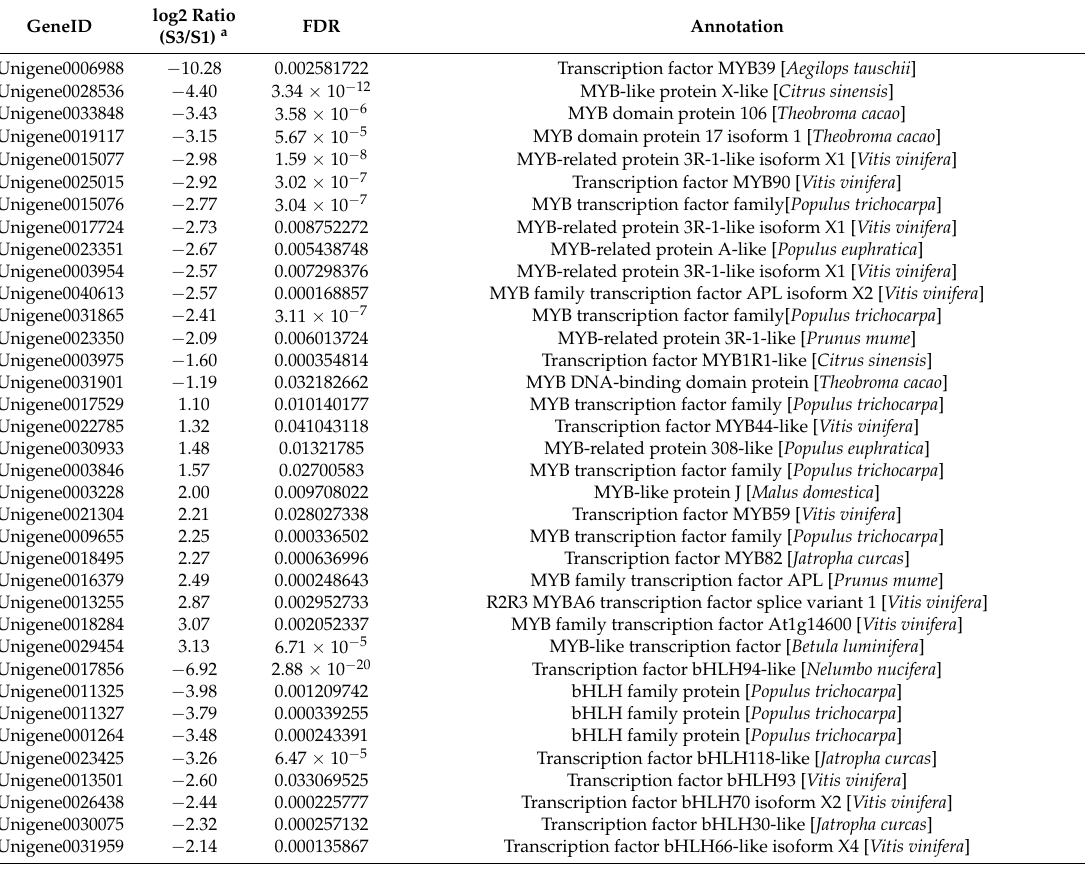
Table 2. Differentially expressed genes in transcription factors of anthocyanin biosynthesis.